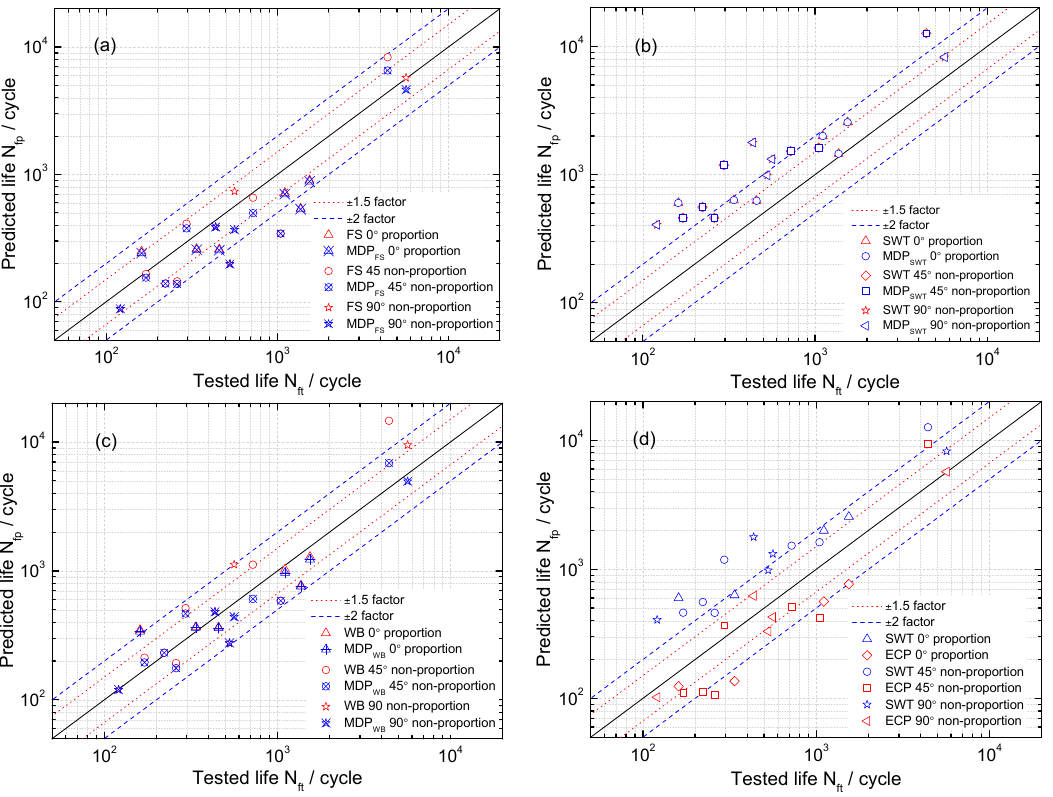
Figure 9. A comparison of predicted life using ( a ) Fatemi-Socie (FS) and MDP FS parameters; ( b ) SWT and MDP SWT parameters; ( c ) Wang-Brown (WB) and MDP WB parameters and ( d ) SWT and energy-critical plane (ECP) parameters under multiaxial fatigue loadings.